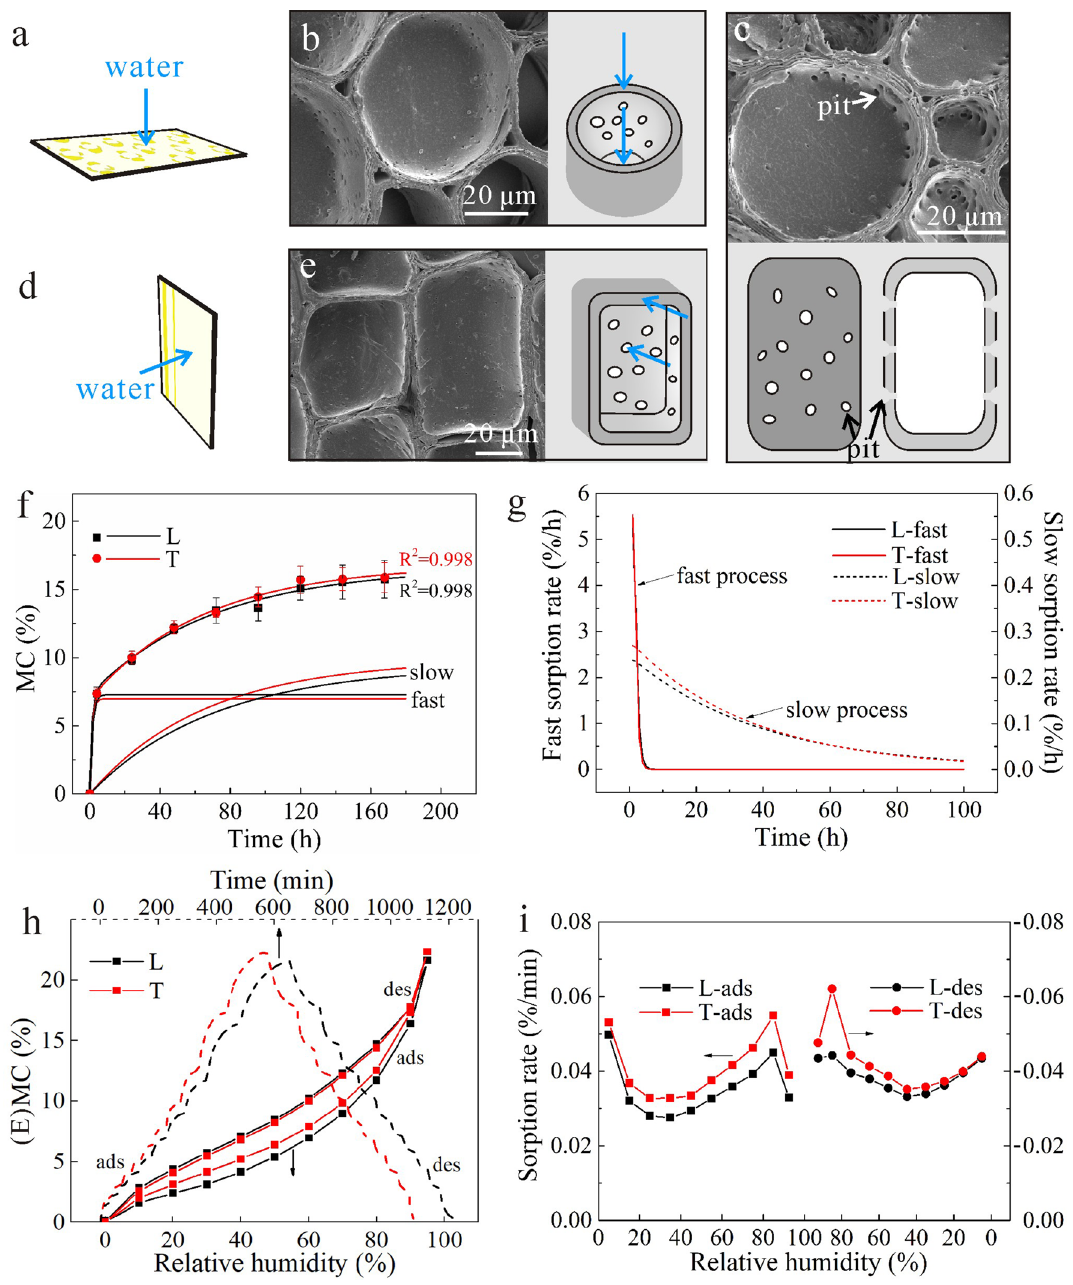
Figure 4. ( a , b ) Structural characterization of 60 μm specimen with longitudinal sorption direction: ( a ) graphical illustration of specimen, ( b ) SEM pictures of parenchyma cells. ( c ) The distribution of pits in parenchyma cells. ( d , e ) Structural characterization of 60 μm specimen with transverse sorption direction: ( d ) graphical illustration of specimen, ( e ) SEM pictures of parenchyma cells. ( f – i ) Sorption behaviors of 60 μm specimens: ( f ) Experimental data (dots) of MC over time by the saturated salt solution method, the PEK fitted curves (lines), and slow and fast processes of PEK model, ( g ) Sorption rates of fast and slow processes, ( h ) The DVS data of MC during whole sorption process (MC change with time from 0 to 1300 min, and EMC change with RH from 0 to 95%), ( i ) Sorptions rates during RH from 0 to former being always higher than the latter, especially at high RH. All these results indicated that the existence of pits created more sorption spaces for water 17 . Siau 27,28 did not consider pits as an important factor for water sorption in wood, below the fiber saturation point. However, in bamboo, since there was no transverse transport tissue, the effect of pits was essential and could not be overlooked. Transverse/longitudinal water sorption in bulk bamboo. When the thickness of the specimen was over 1 mm, most of the cells were intact, and thus it was necessary to include the sorption of bound-water in cell